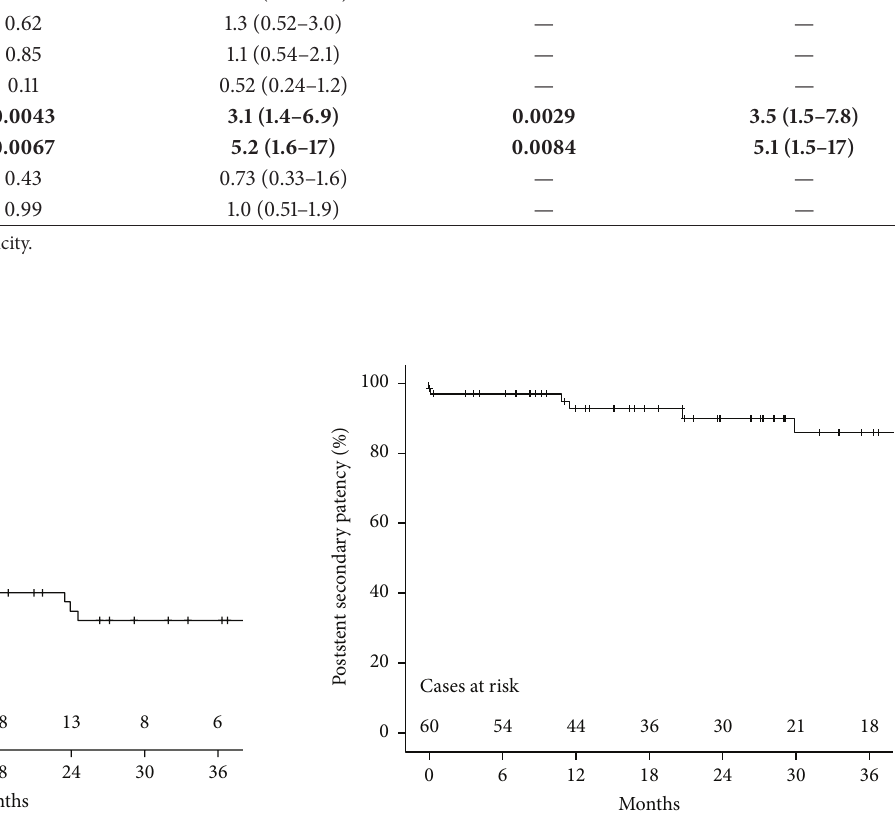
Figure 3: Kaplan-Meier estimate of postintervention secondary patency after stent placement.